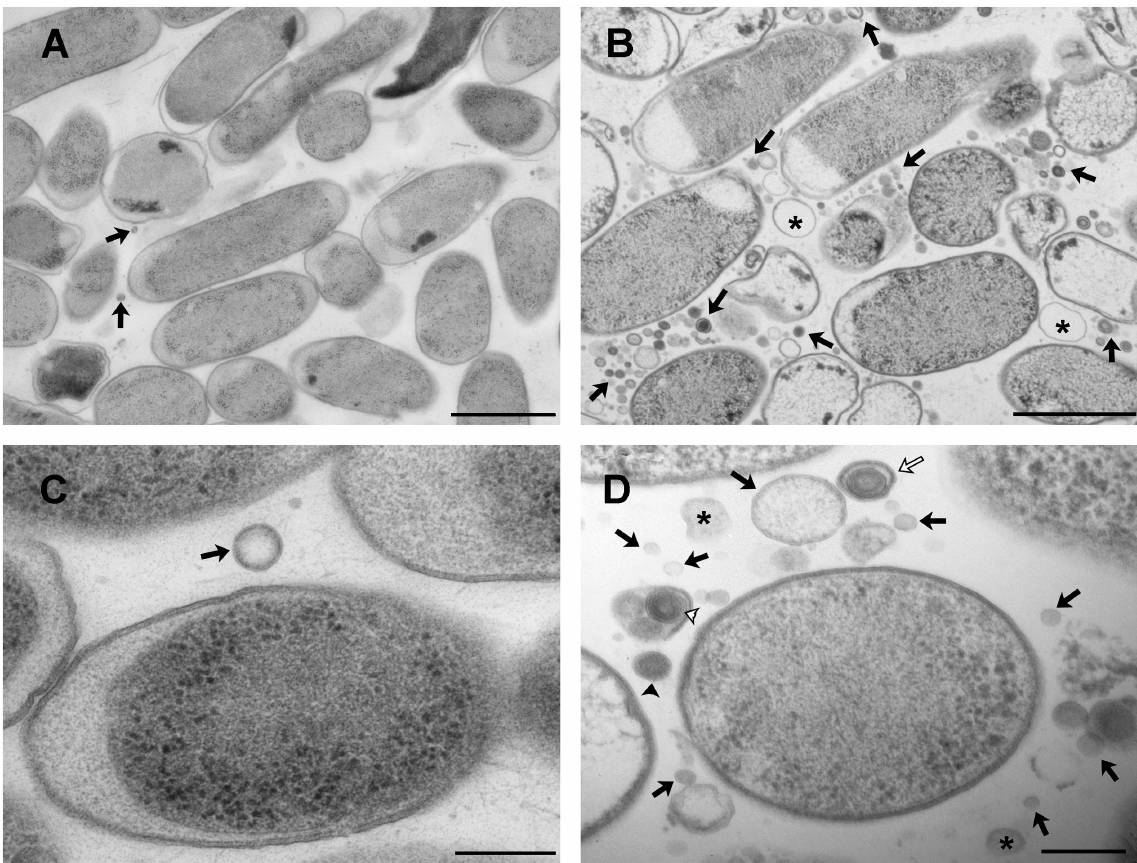
Fig 3. TEM micrographs of ultrathin sections from EcN and EcN tolR strains prepared by HPF-FS. (A) A representative micrograph of EcN cells in which few MVs are observed (arrows). (B) A representative micrographof EcN tolR cells in which a huge amount of MVs can be observedinterspersed among cells (arrows). Asterisks indicate biggerempty vesicles. (C) A magnifiedview of EcN cells in which a common OMVs with one bilayer is observed (arrow). (D) A magnifiedview of EcN tolR cells in which the following types of MVs are seen: common MVs (OMVs) indicatedby black arrows; two bilayer vesicles(O-IMVs) by black arrow heads; multi- layered vesicles by white arrows; groupedvesicles by white arrow heads, and partiallycircularizedmembranes by asterisks. Representative images of thin-sections from two different experiments are shown. Bars A–B are 1 μ m, C–D are 200 nm.